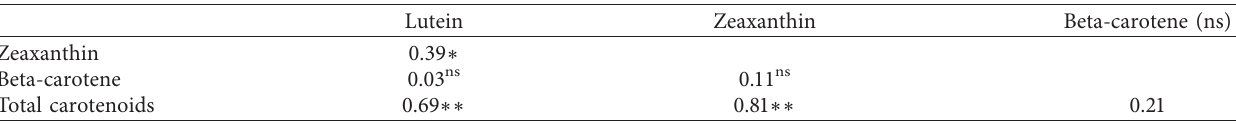
Table 5: Pearson’s correlation coefficients between total carotenoids and carotenoids fractions of small-ear waxy corn